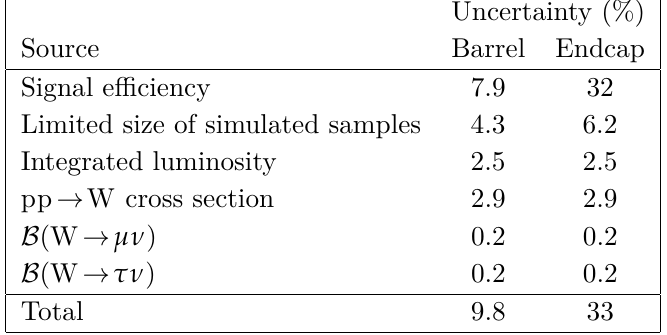
Table 1 . Sources of systematic uncertainties in the W boson analysis and their effect on the signal efficiency and normalization for the barrel and endcap